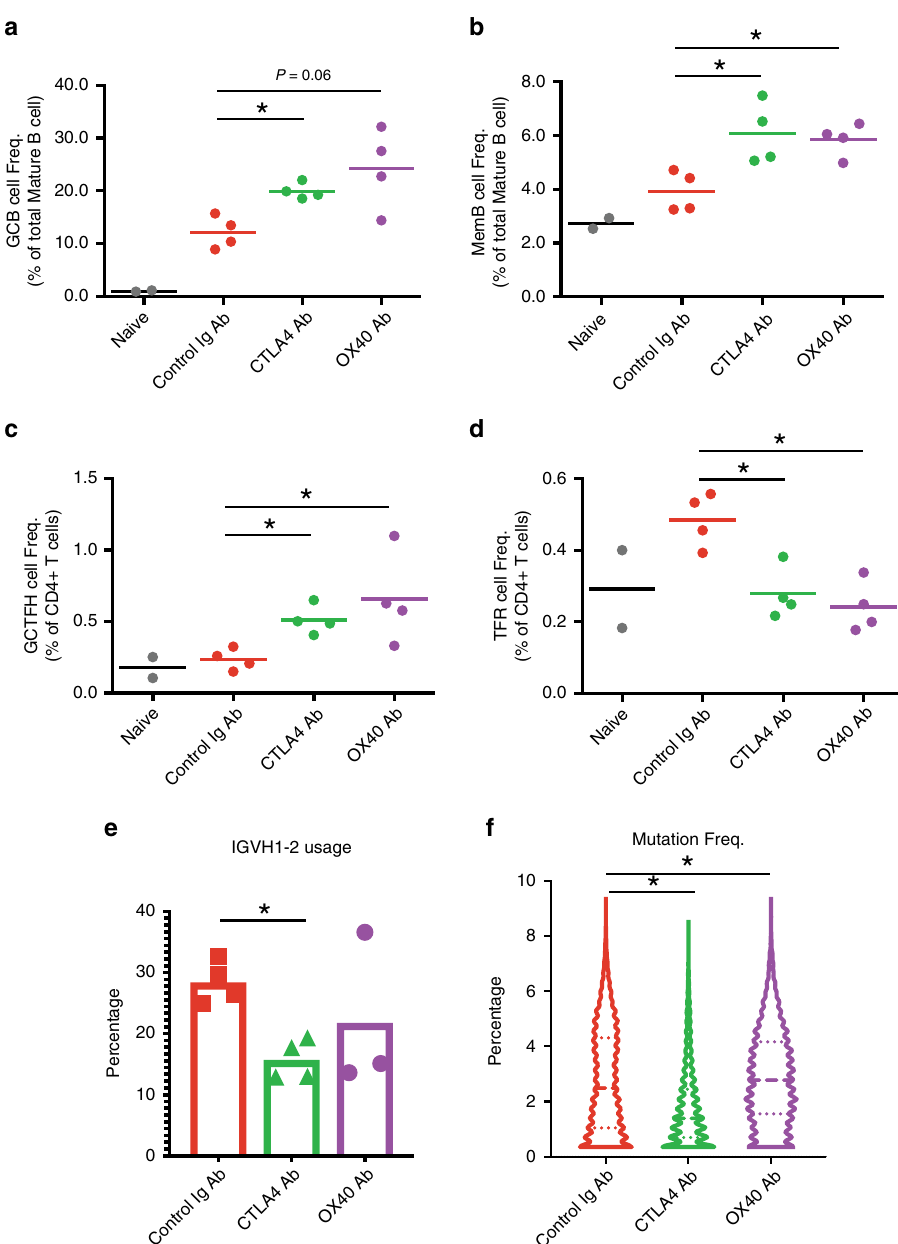
Fig. 6 Co-administration of CTLA-4 or OX40 altered splenic germinal center cell frequencies and repertoire in VRC01 precursor mouse after immunization. a – d Frequencies of splenic ( a ) Germinal center B cells and ( b ) memory B cells ( c ) germinal center CD4 + T follicular helper cells and ( d ) germinal center T follicular regulatory cells in each group after immunization at week 11. Each dot represents a single animal and are colored based on antibody treatment group (Control Ab, red; CTLA4 Ab, green; OX40 Ab, purple). e , f Sequencing of germinal center B cell IGHV genes by HTGTS-Rep-Seq. e Fraction of GC B cells HTGTS-Rep-Seq reads that utilize the human IGHV1-2*02 gene. Each dot represents the individual animals and the bars indicate the group means. f Violin plots of the frequency of mutation from germline of IGHV1-2*02 reads that contain at least a single mutation. * P < 0.05, Wilcoxon – Mann – Whitney. Source data are provided as a Source Data fi